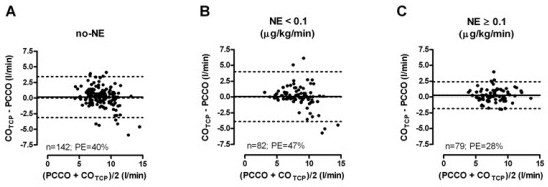
Bland-Altman plots of different norepinephrine (NE) subgroups. PCCO, pulse contour cardiac output; COTCP, transcardiopulmonary thermodilution cardiac output; PE, percentage error; solid line, mean bias; dotted lines, limits of agreement.